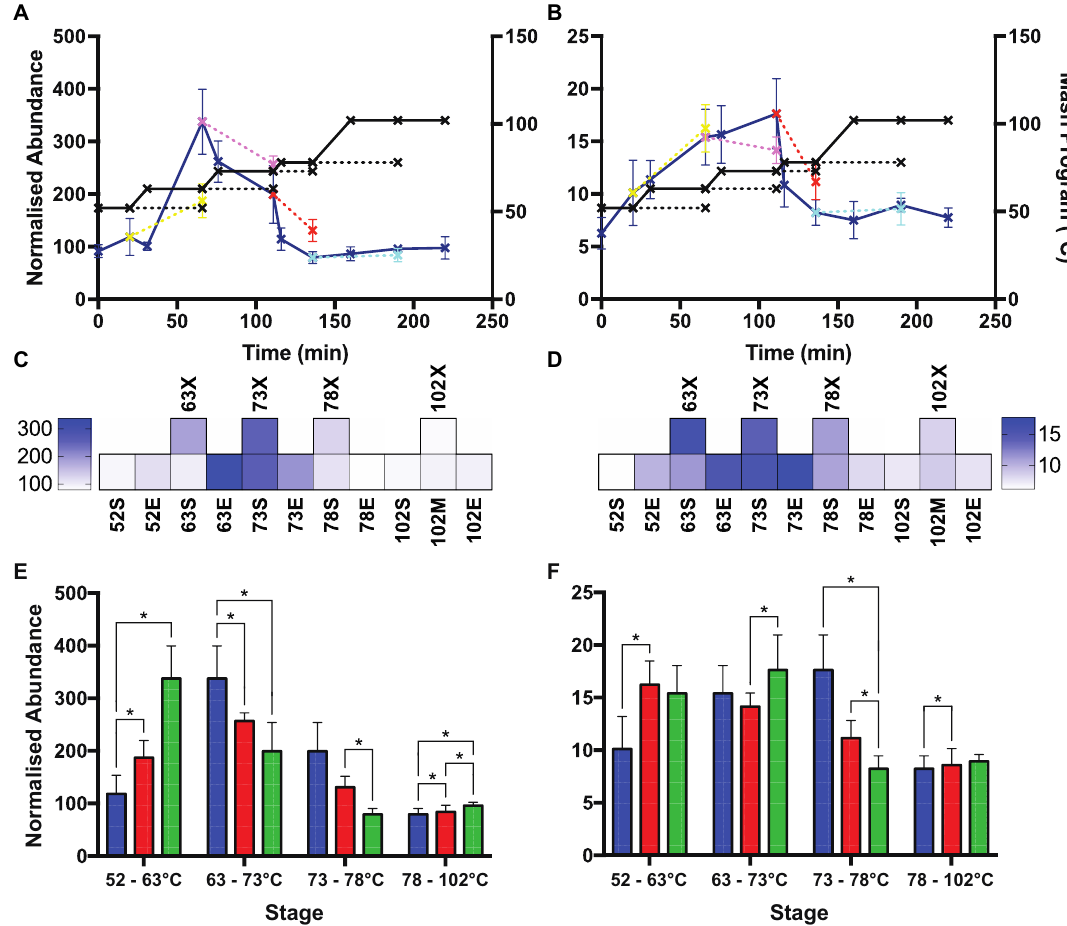
Figure 5. The effect of time and temperature on protein abundance during the mash and boil in a 1 mL micro- scale mash. Normalised abundance of ( A ) NLTP1 and ( B ) IAAA. Standard mash program, solid line, dark blue; rest stage temperature extensions, dotted lines. Heat map of normalised abundance of ( C ) NLTP1 and ( D ) IAAA. Standard mash program, bottom row; rest stage temperature extensions, top row. Comparison of normalised abundance between sequential stages for ( E ) NLTP1 and ( F ) IAAA). First stage, blue; time extension of first stage, red; next temperature stage, green. All values show mean, n = 3. Error bars, SEM. *, statistically significant ( p <